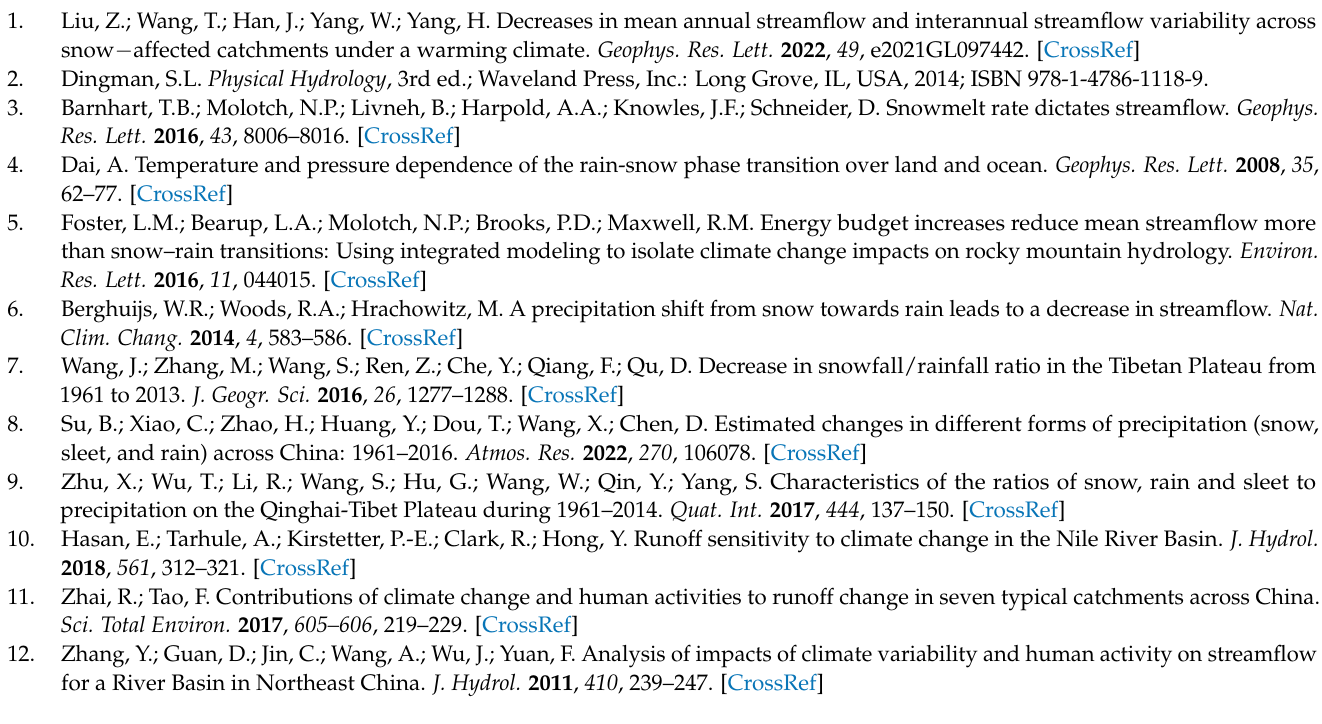
Table S2: Information for hydrological